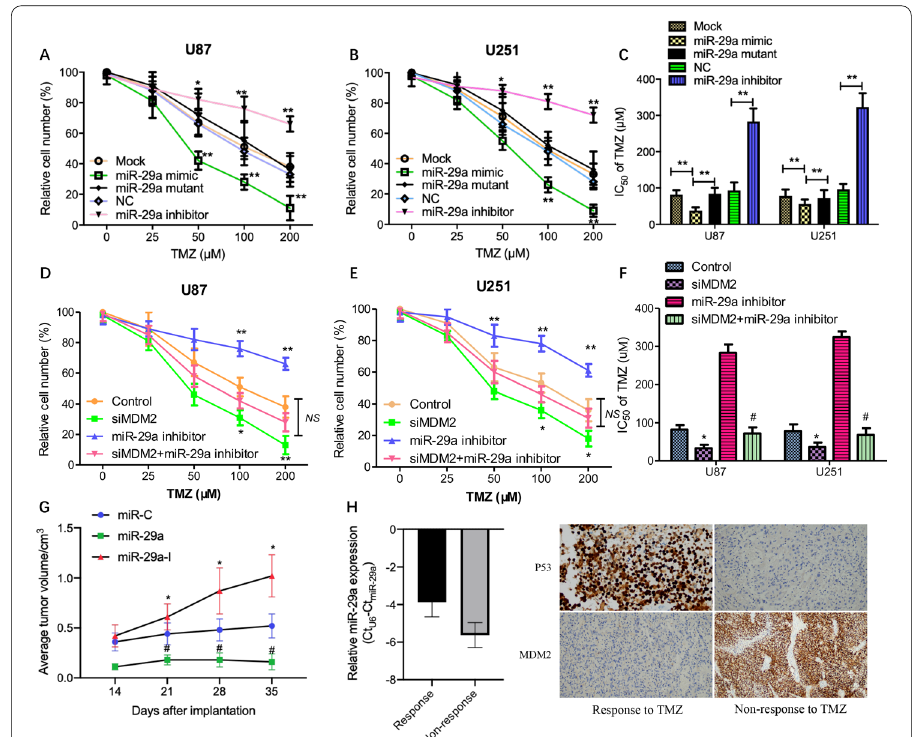
Fig. 5 P53-miR-29a-MDM2 positive feedback loop sensitized the response of glioma cells to temozolomide. A , B After using a serial concentration of TMZ to treat glioma cells with miR-29a mimic, inhibitor or corresponding control transfection, cell viability was detected by CCK-8 assay. C IC 50 for TMZ was determined in glioma cells mentioned above. Results show the mean SD (n 3). *P < 0.05; **P < 0.01. D , E After MDM2 ± = knockdown followed by miR-29a inhibitor treatment, cell viability was detected by CCK-8 assay; meanwhile IC 50 for TMZ was determined in these cells ( F ). *P < 0.05 vs control; # P < 0.05 vs miR-29a inhibitor. U87 cells stably expressing miR-C (control), miR-29a, or miR-29a-I (inhibitor) were resuspended in 200 μL of FBS-free DMEM medium and then subcutaneously injected into each side of the posterior flanks of nude mice (n 6). The tumor growth curve in vivo was analyzed ( G ). Furthermore, tumor tissues from patients receiving = TMZ treatment and achieving a better response and from patients receiving TMZ treatment but without a response were collected for the evaluation of miR-29a, p53 and MDM2 expression by RT-PCR and IHC ( H